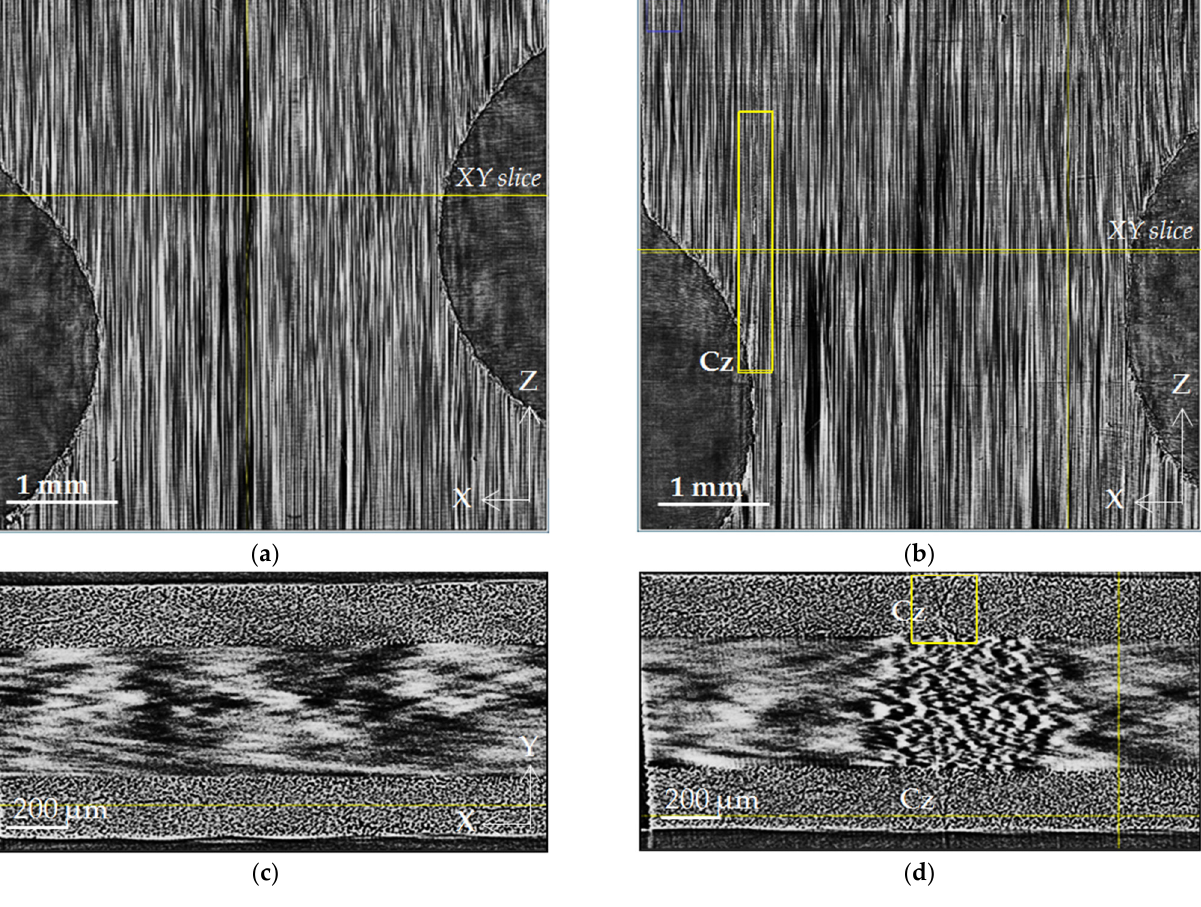
Figure 3. Microstructure of cross-ply CFR plastic in the [0°] layer: ( a ) initial state, 38 MPa; ( b ) loaded state, 865 MPa; ( c , d ) XY slices of the initial and loaded states, located as indicated in Figure 3a,b. Cz designates cracks spreading along the Z-axis, and K marks the kinking of the fiber package. The tension load was applied along the Z-axis.